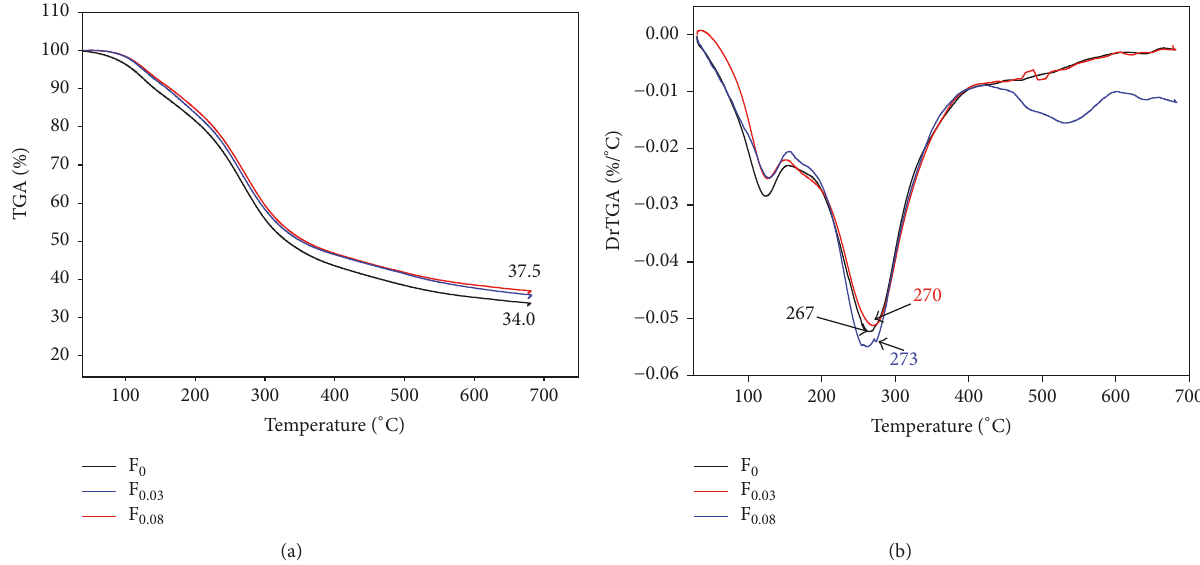
Figure 5: (a) The TGA curves of composite films (F 0 , F 0.03 , and F 0.08 ). (b) The DTG curves of composite films (F 0 , F 0.03 , and F 0.08